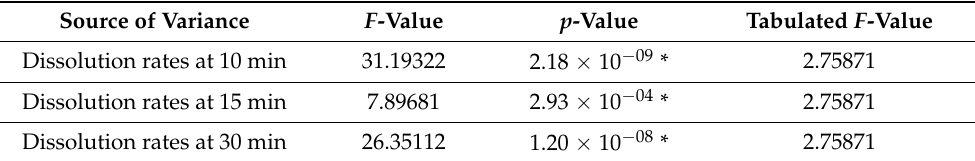
Tabulated F -Value